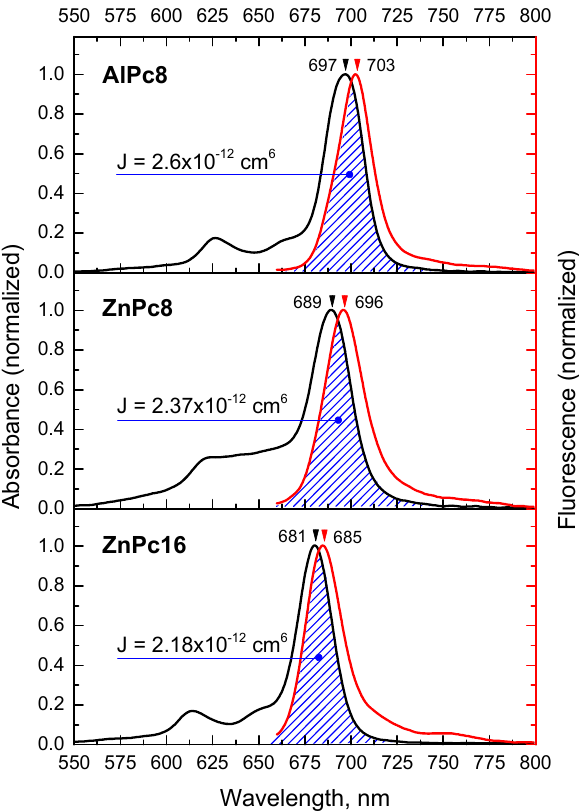
Figure 1. Normalized absorption and fluorescence spectra of carboxyphthalocyanines. The spectra were obtained for a 1 µ M solution in distilled water. The overlap of absorption and fluorescence spectra and corresponding integral value are indicated, as well as the position of the maximum of the Q I absorption band and the Pc fluorescence spectrum.